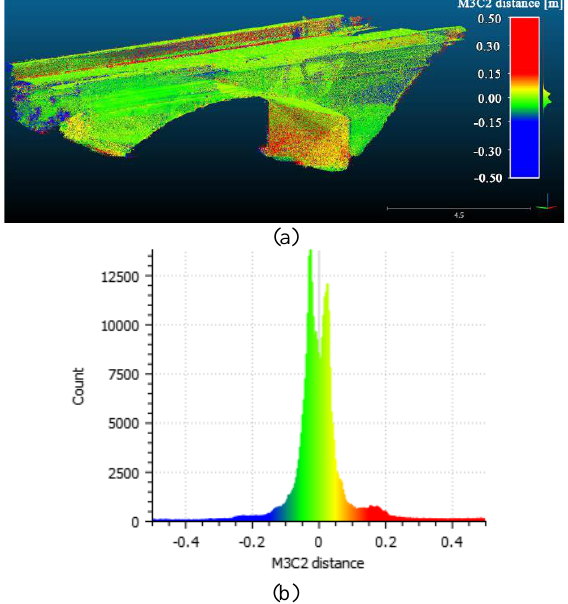
Figure 10. (a) Distances between the L1 LiDAR point cloud and the TRAD integrated point cloud (computed with the M3C2 algorithm in Cloud Compare). Points with red and blue